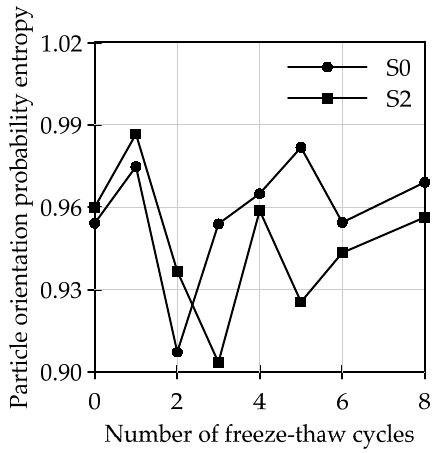
Figure 10. The curve of H m and F-T cycles.